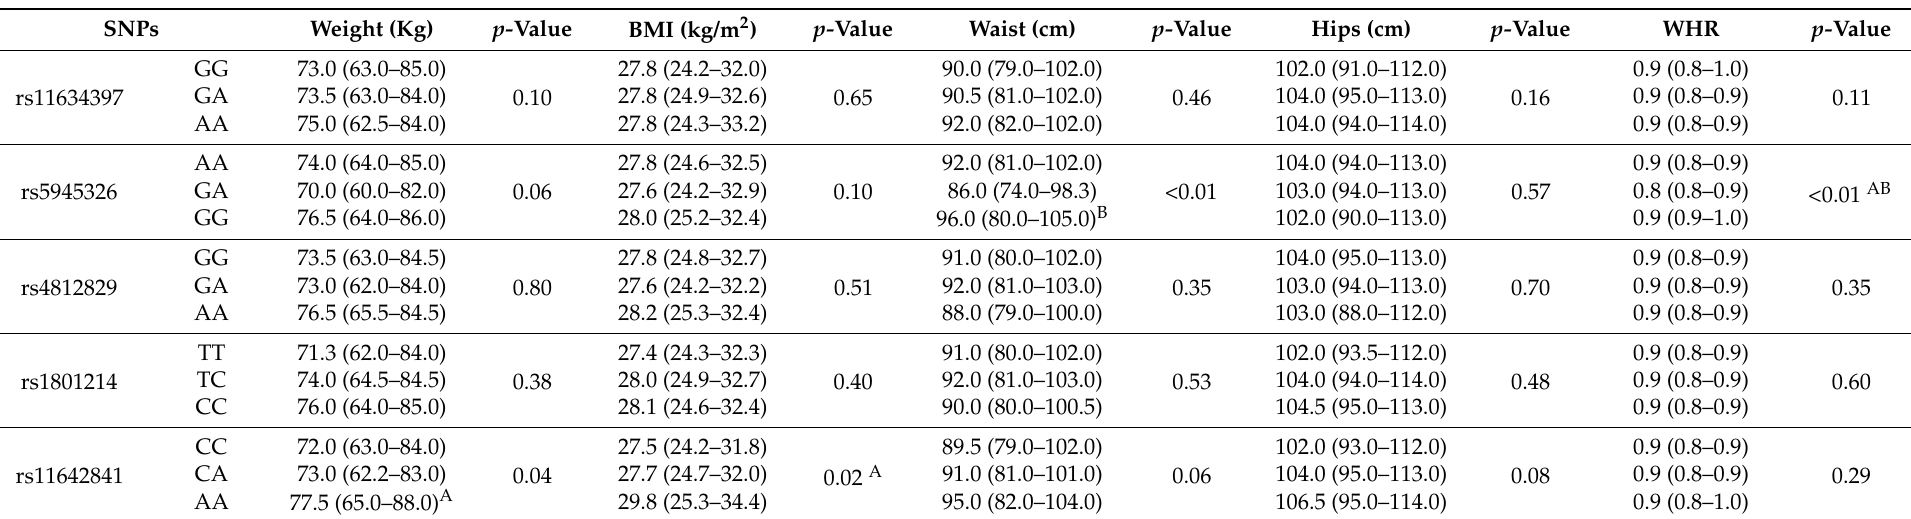
Table 3. Anthropometric data according to selected